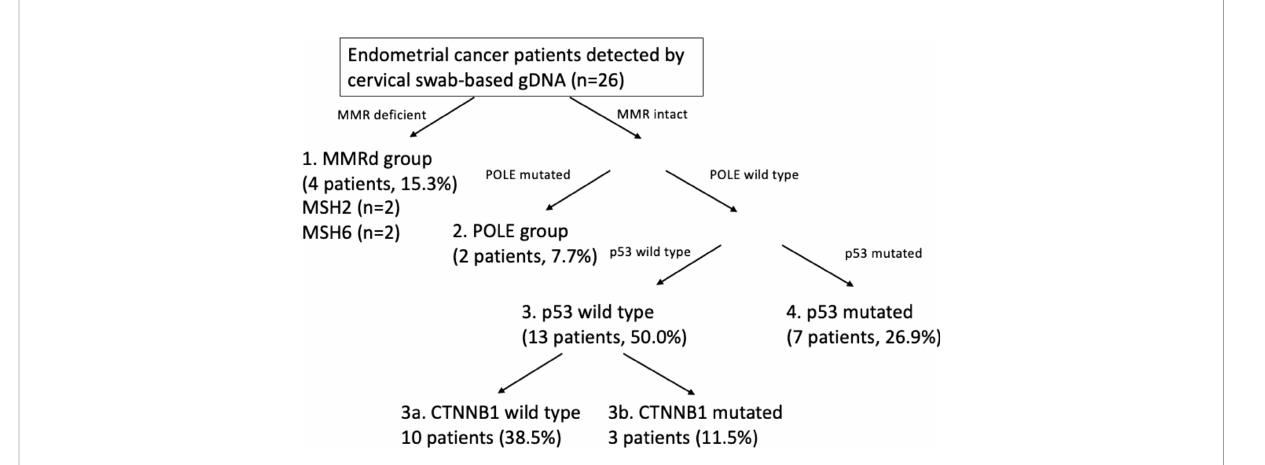
FIGURE 4 Application of the Proactive Molecular Risk Classi fi er for Endometrial Cancer (ProMisE) based on cervical swab-based genomic